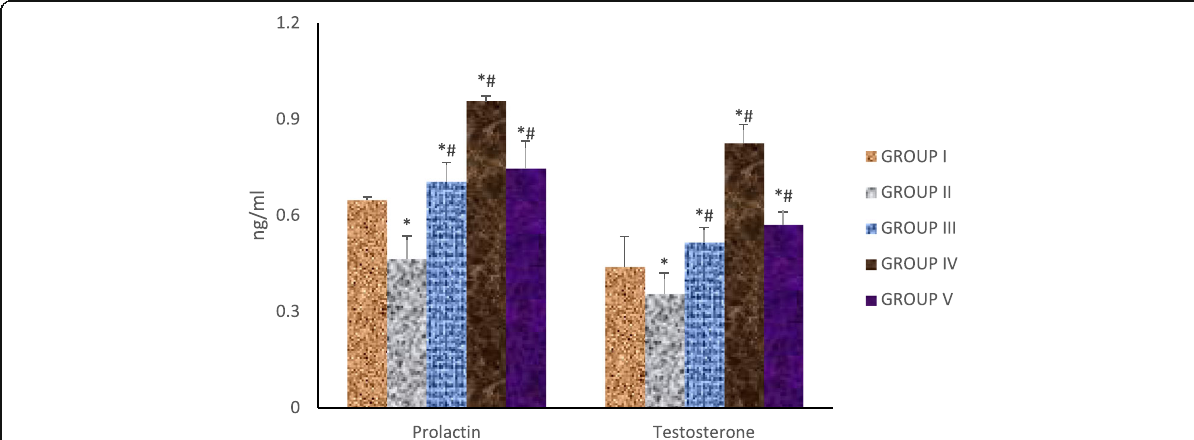
Fig. 3 Effect of MLVA on testosterone and prolactin of rats treated with nitrobenzene. Data are given as mean ± SD of rats per group. n = 6. MLVA: methanolic leaf extract of Vernonia amygdalina , *: Values differ significantly from group I (control) ( P < 0.05). #: Values differ significantly from group II